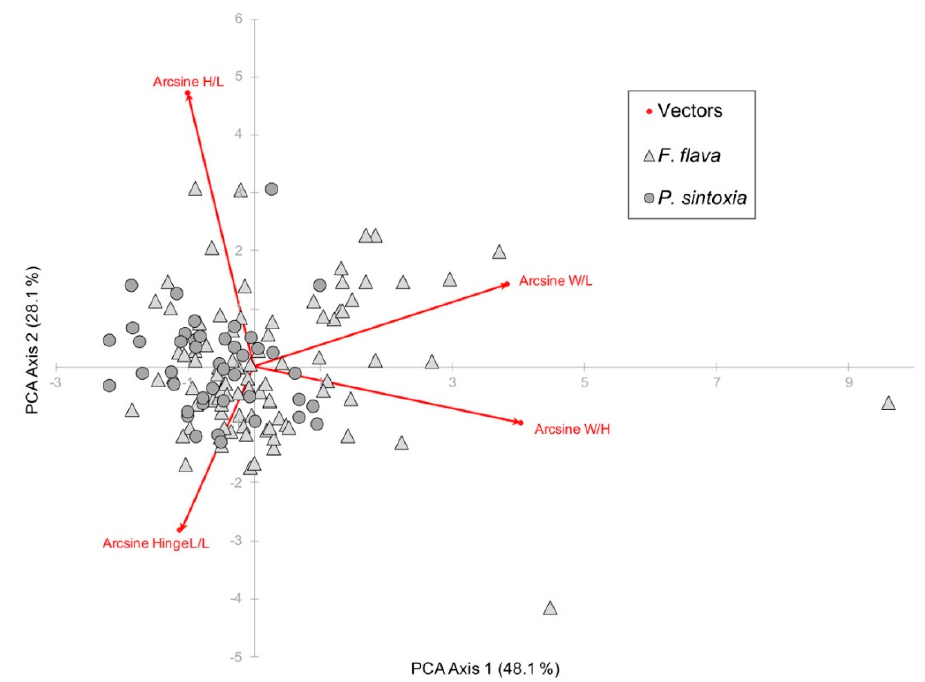
Figure 2. Principal components analysis (PCA) biplot for arcsine transformed shell height / length (H / L), width / length (W / L), width / height (W / H), and hinge length / length (HingeL / L) of F. flava and P. sintoxia specimens.